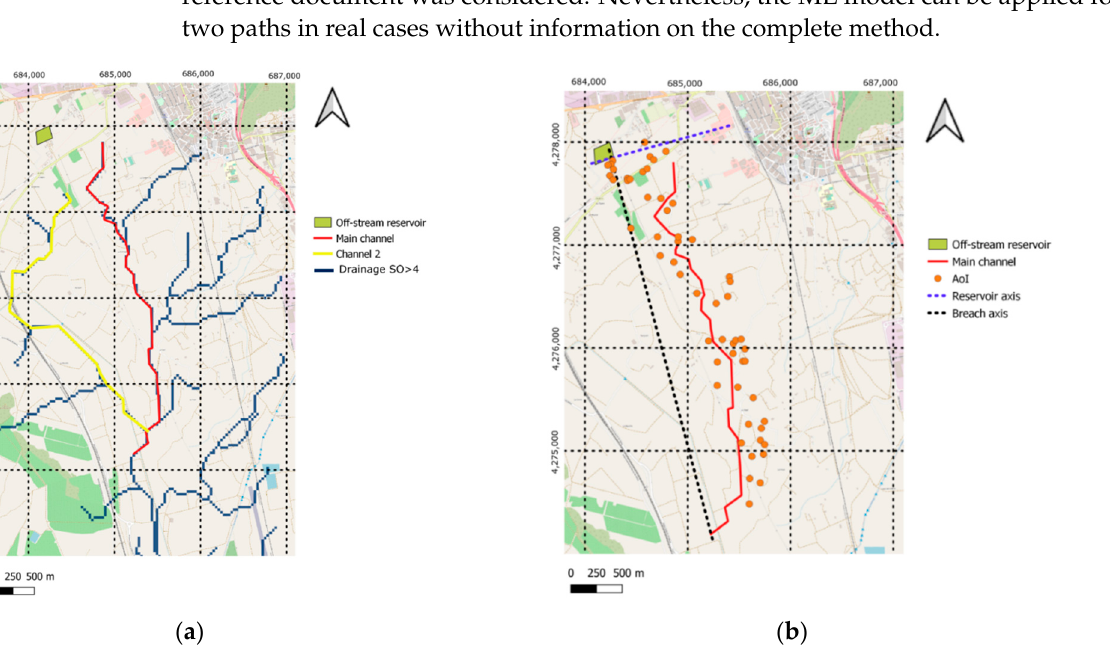
Figure 12. ( a ) Drainage network (Strahler order larger than 4) and selected main channel (red line); ( b ) Location of AoI, main channel, breach and reservoir axes. x and y axes represent UTM coordi- nates.